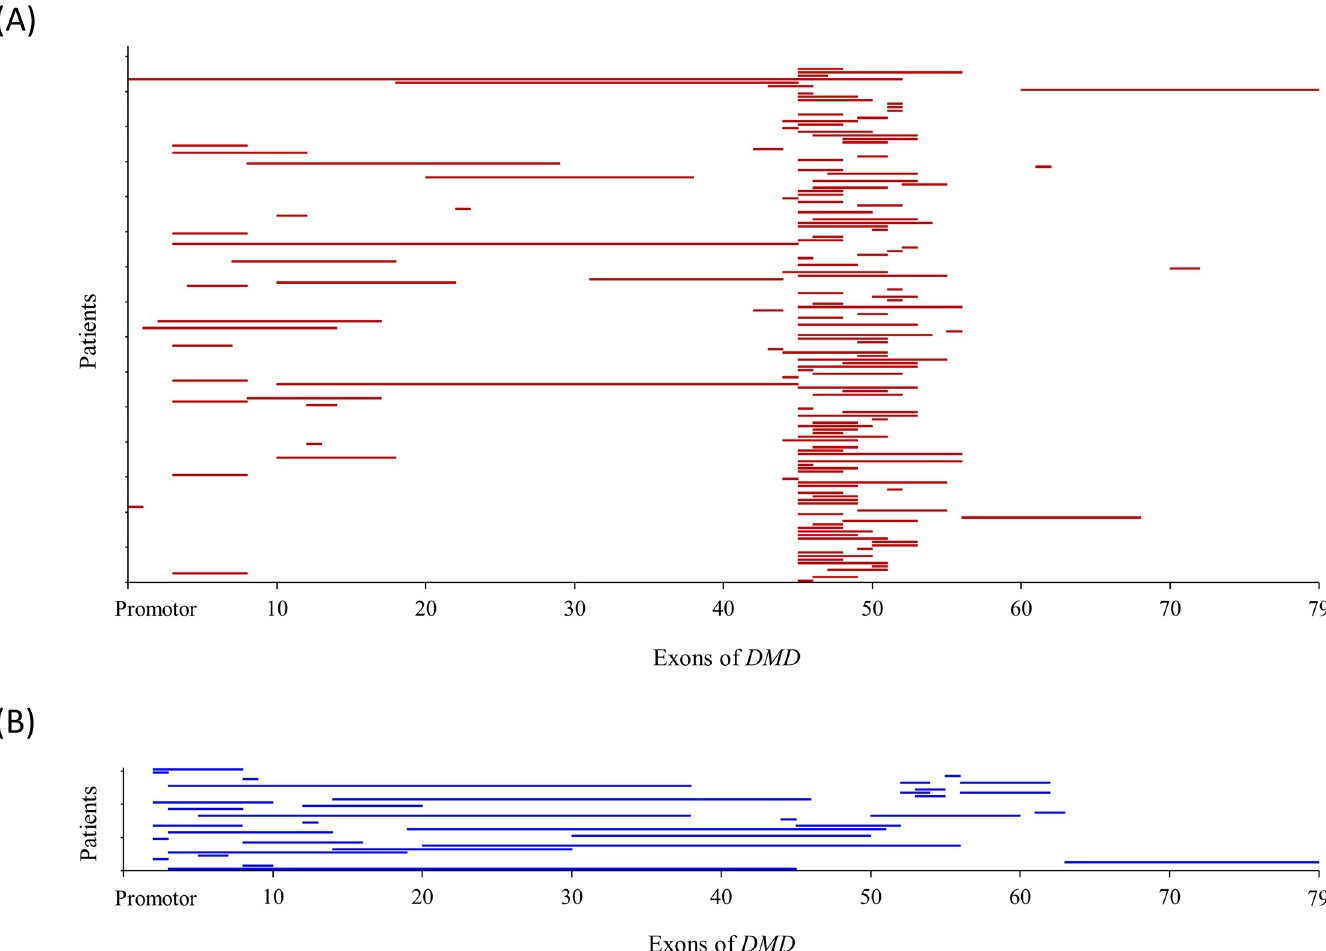
Fig 3. Distribution of large rearrangements in 178 probands with dystrophinopathy. Red (A) and blue (B) colors indicate exonic deletions and exonic duplications,